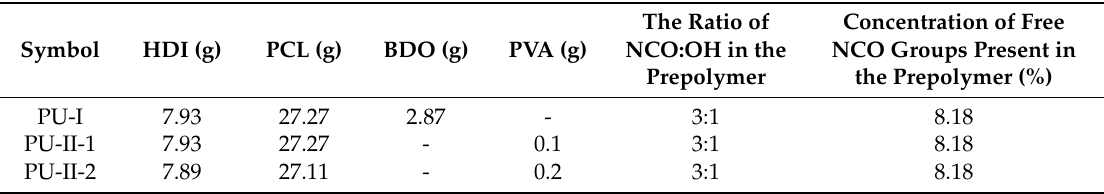
Table 1. Symbols of obtained PURs and their detailed